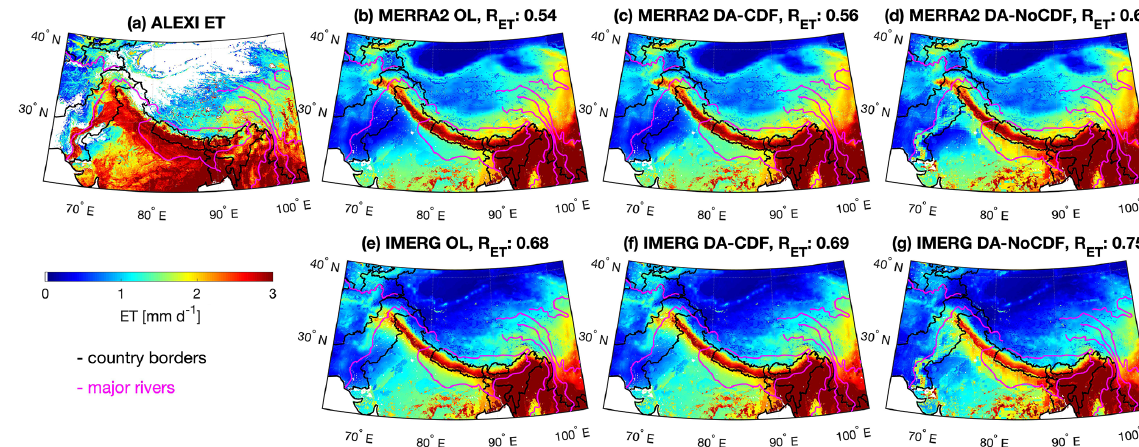
Figure 7. Comparative maps of modeled evapotranspiration (ET) with respect to the ALEXI evapotranspiration estimates (Sect. 3.2.3) for WY 2016. DA-NoCDF maps show relatively higher spatial consistency with ALEXI ET, particularly in areas surrounding the major rivers in lower latitudes ( < 30 ◦ ). The correlation values ( R ET ) indicate the spatial consistency between annual mean ET estimated by ALEXI and the corresponding Noah-MP simulation.